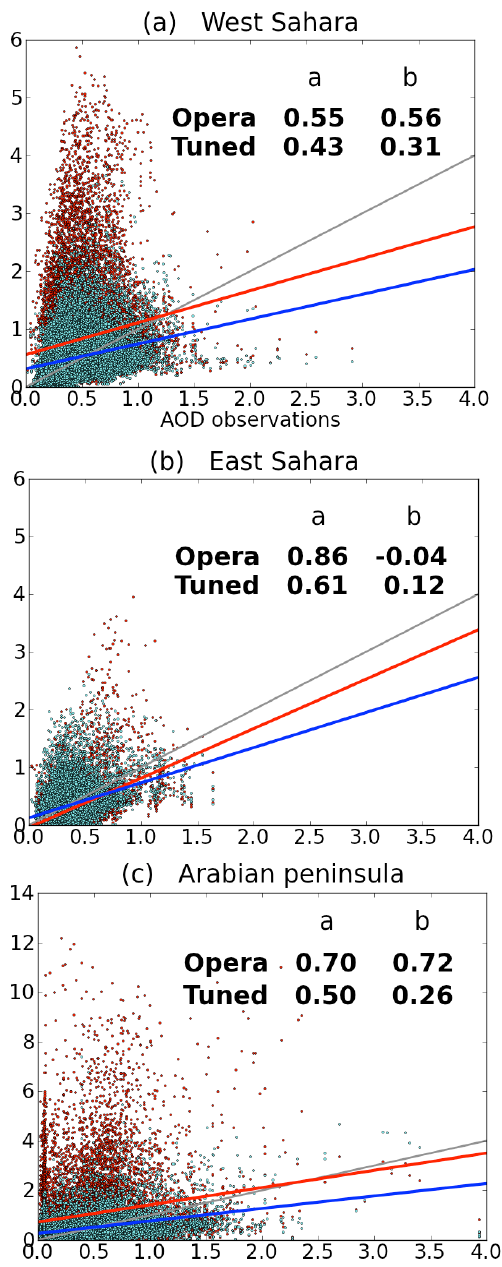
Fig. 14. The scatter plots of forecast AOD (24h lead time) and AOD observations. (a) corresponds to the box containing point S in Fig. 12a. (b) corresponds to the box containing point U in Fig. 12a. (c) corresponds to the box containing point N in Fig. 12a.